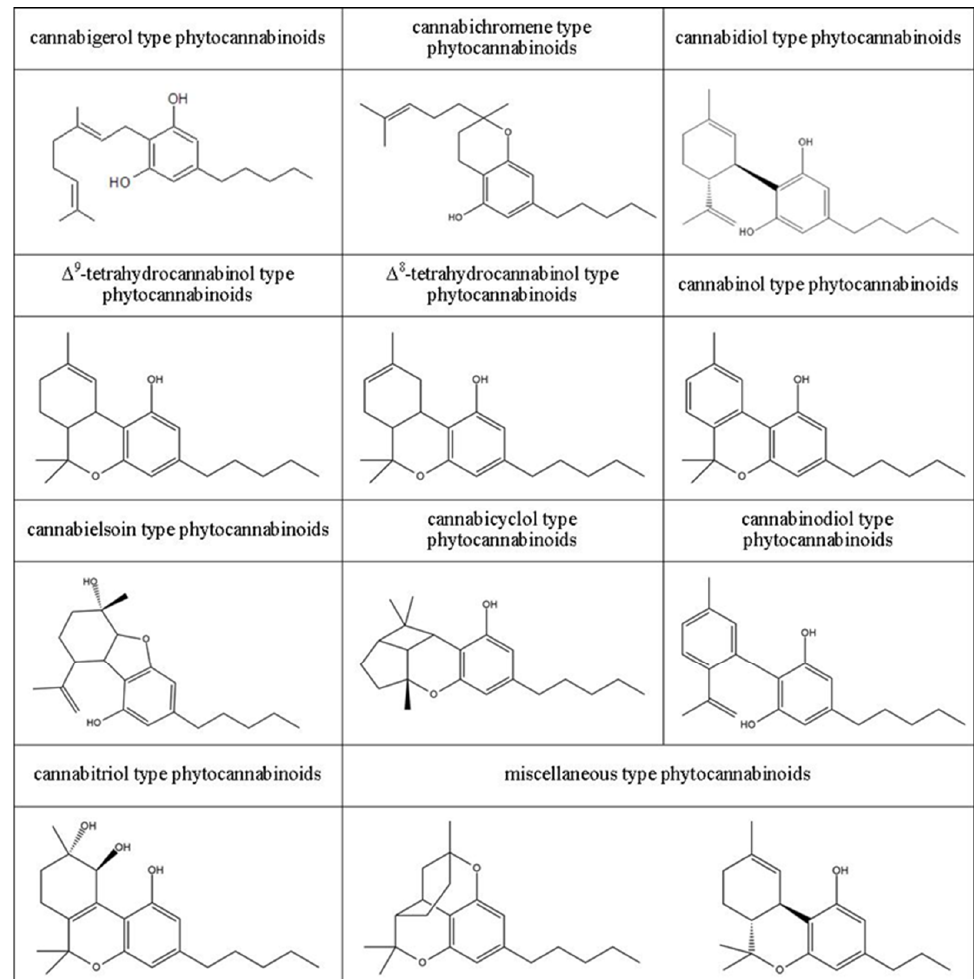
Figure 1. Division of phytocannabinoids by chemical structure along with chemical formulas of the main representatives of each class.